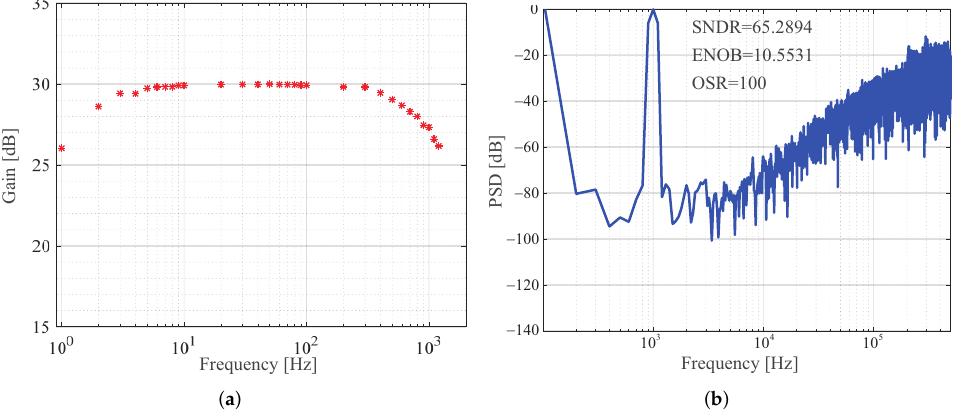
Figure 13. ( a ) Measured frequency response of the proposed AFE. ( b ) Measured output spectrum of the